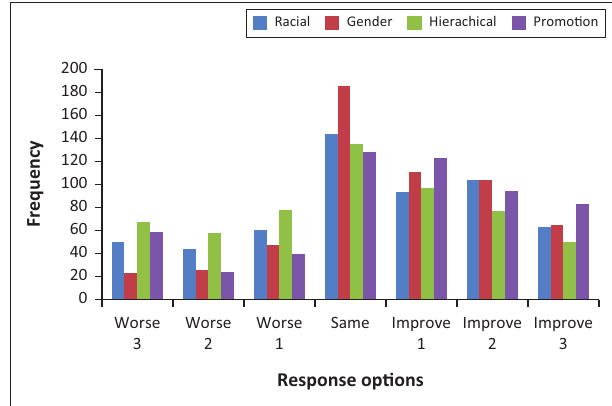
FIG URE 1: The influence of the EEA on racial, gender and hierarchical relationships and promotion in the workplace. TABLE 3: Statistical significant differences as they relate to Question 1. Question 1: In the facility where you are employed, has the application of the EEA improved or worsened… Q1.1 …racial relationships?